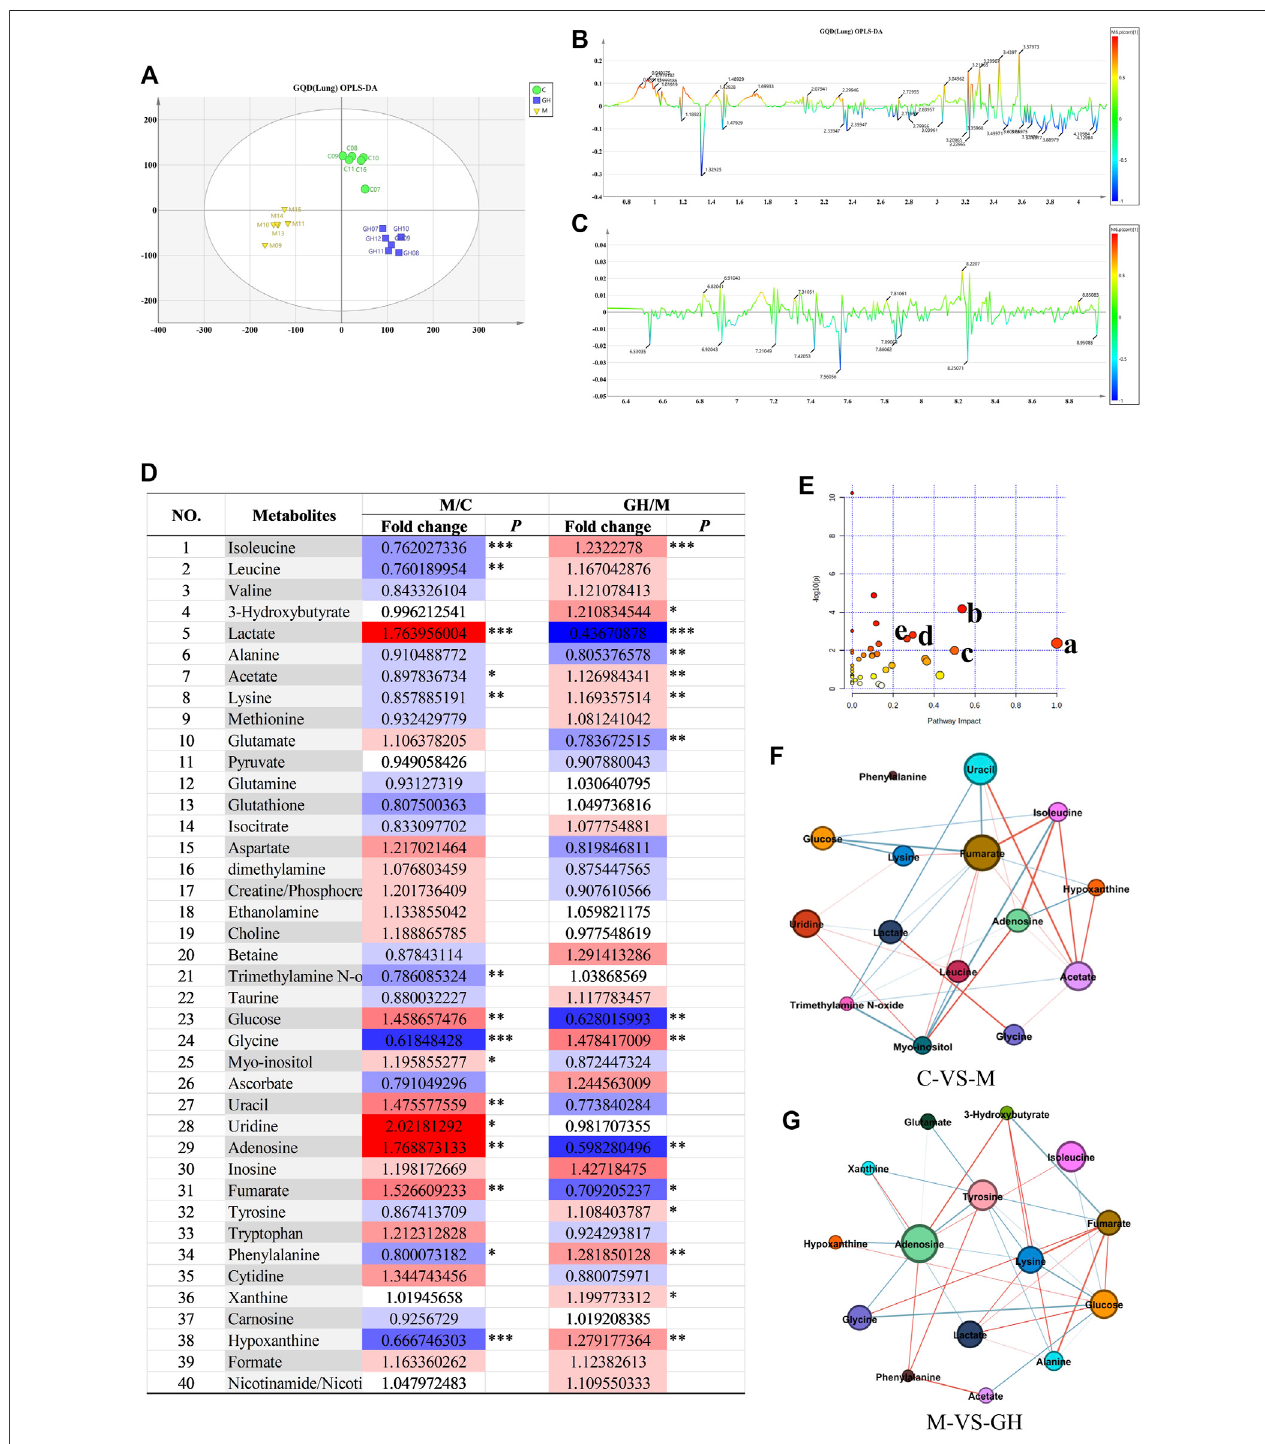
FIGURE 3 | Analysis of lung tissue metabolites of GQD on ALI induced by LPS in rats. (A) OPLS-DA analysis, the abscissa is the main component T1, and the ordinateisthemaincomponentT2.BlueisGQDtreatmentgroup,yellowismodelgroup,greenisblankgroup. (B) OPLS-DAloaddiagramofhigh fi eldregion, (C) OPLS- DA load diagram in low Field region, the horizontal axis is the chemical shift, and the vertical axis is the P (corr) value of the difference between groups. The greater the absolute value of the vertical axis, the greater the difference between groups of metabolites at the chemical shift. (D) Univariate analysis Color Table, the color coding is performed according to the change in magni fi cation (FC). The darker the color, the higher the signi fi cance, the darker the red, the higher the positive magni fi cationofthedifferencebetweenthetwogroups,andthedarkertheblue,thehigherthereversemagni fi